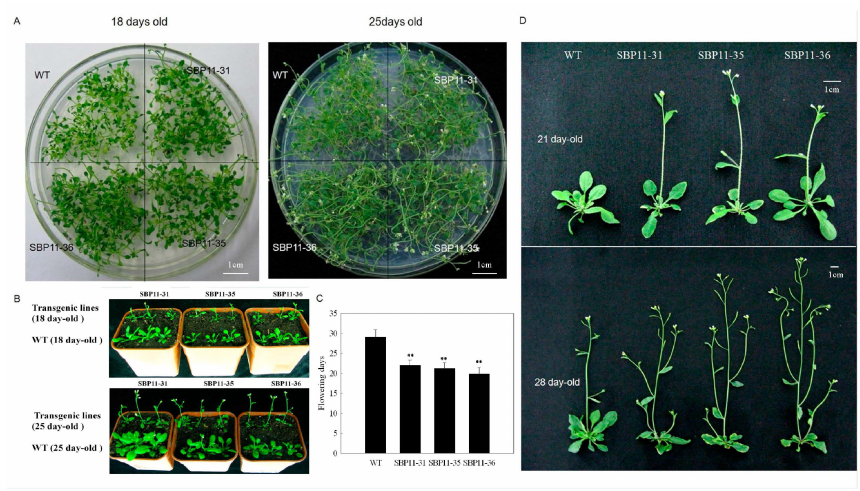
Figure 3. Phenotypes of A. thaliana wild-types (WT) and transgenic lines overexpressing VpSBP11. ( A ) Three transgenic lines and WT grown together in the same petri dish (18 and 25 days), scale bars: 1 cm; ( B ) Three transgenic lines and WT grown together in the same pot (18 and 25 days); ( C ) Statistics about flowering times of 100 plants of three transgenic lines and WT grown together in the same pot. Asterisks indicate statistical significance (** p < 0.01, one-way ANOVA); ( D ) Phenotypes of three T3 generations of transgenic plants and WT (21 and 28 days). The experiments were repeated three times with consistent results, scale bars: 1